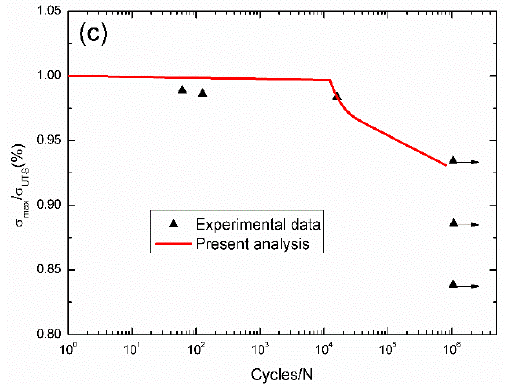
Figure 15. ( a ) The interface shear stress versus applied cycles; ( b ) the broken fiber fraction versus applied cycles; and ( c ) the fatigue life S–N curves of experimental data and theoretical analysis for 3D C/SiC composite at 1300 °C in vacuum.